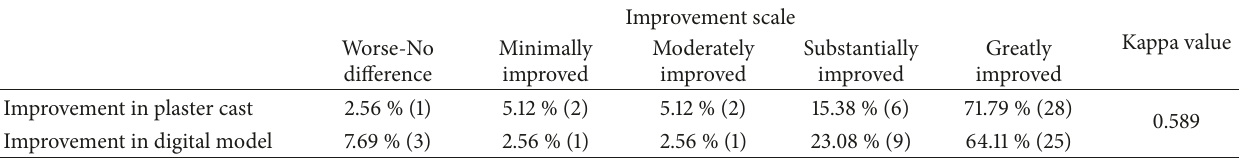
Table 4: Agreement of the categorization of improvement in occlusion with respect to ICON